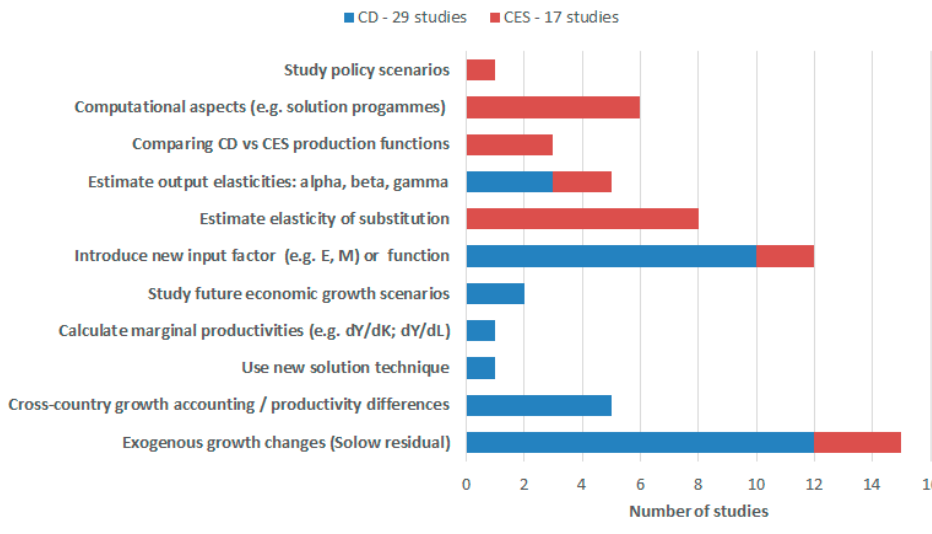
Figure 2. Primary study rationale in the sample.